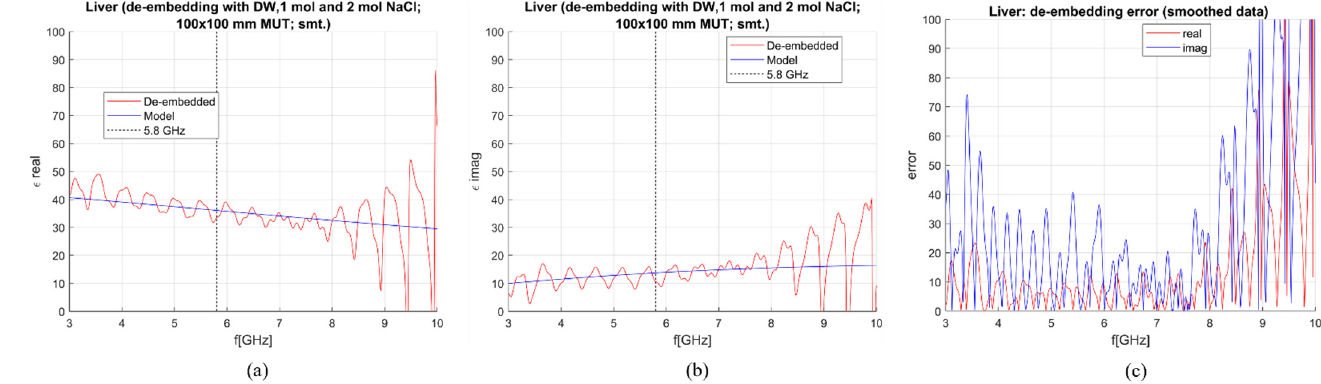
Figure 9. S&S de-embedding with the 3rd calibration option: DW, 0.1 mol and 2 mol NaCl (smoothing applied): ( a ) Calculated vs. reference ε ’; ( b ) calculated vs. reference ε ’’; ( c ) sensitivity (de-embedding error) for ε ’ (“real”) and ε ’’ (“imag”).